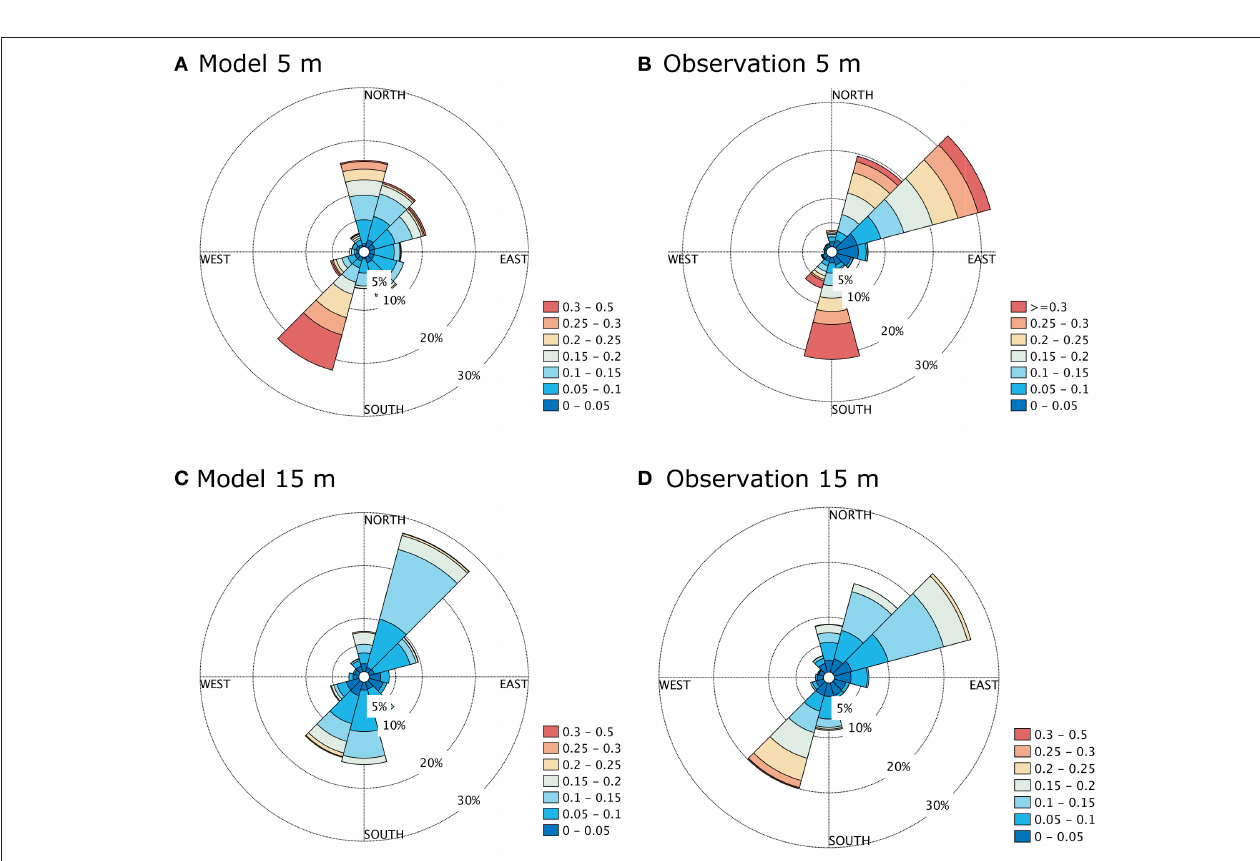
FIGURE 6 | Current rose distribution plots of simulated (A,C) and measured (B,D) water velocities at the south end of array II at location 2 (labeled “S” in Figure 5 ). The upper (A,B) panels show velocities for 5m depth. The lower panels show velocities for 15m depth. The position of the S station was 64.7813 ◦ N, 8.5264 ◦ E. The measurements and corresponding SINMOD simulation were made for the period 29 January to 26 February, 2010.